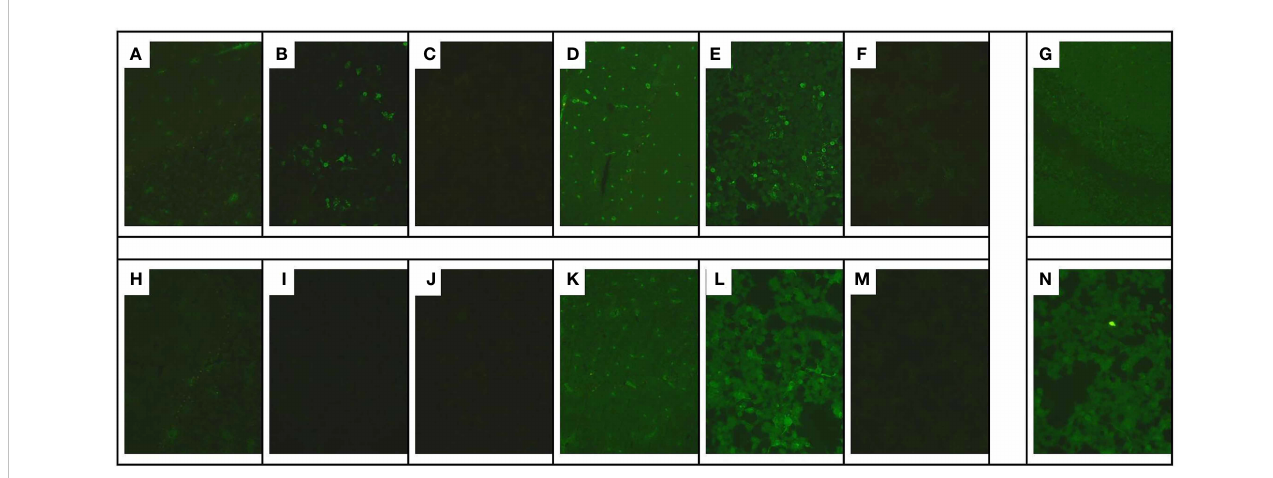
FIGURE 2 Immuno fl uorescence staining of monkey cerebellar tissues. Cryosections of the monkey cerebellum were incubated with patient serum and CSF in the fi rst step and with FITC-labeled goat anti-human IgG in the second step. Immuno fl uorescence of anti-NMDAR and anti-mGluR5 antibodies in the CSF and serum of the patient. Anti-mGluR5 and anti-NMDAR antibodies bound on mGluR5 and NMDAR antigens expressed in HEK293 cells, respectively, and visualized by the immuno fl uorescence of fl uorescein on the second antibody. (A) Tissue-based indirect immuno fl uorescence assay of CSF displayed anti-NMDAR antibody presenting as granular fl uorescence in monkey cerebellar granular layer cells. ×200 magni fi cation. (B) Positive reaction with transfected HEK293 cells expressing NMDAR after incubation with the patient ’ s fi rst CSF (B) (titer 1:3.2). ×200 magni fi cation. (C, I) Negative reaction with transfected HEK293 cells expressing mGluR5 after incubation with the patient ’ s fi rst CSF (C) and the repeated CSF (I) . ×200 magni fi cation. (D, G, J, M) Tissue-based indirect immuno fl uorescence assay of the patient ’ s fi rst serum (D) , second CSF (G) , second serum (J) , and third serum (M) showed no speci fi c form of fl uorescence in the monkey cerebellum. (E, K, N) Positive reaction with transfected HEK293 cells expressing NMDAR after incubation with the patient ’ s fi rst serum (titer 1:32) (E) , second serum (titer 1:32) (K) , and third serum (titer 1:10) (N) . (F) Positive reaction with transfected HEK293 cells expressing mGluR5 after incubation with the patient ’ s fi rst serum (F) (titer 1:10). ×200 magni fi cation. (H) Negative reaction with transfected HEK293 cells expressing mGluR5 after incubation with the repeated CSF (H) . ×200 magni fi cation. (L) Negative reaction with transfected HEK293 cells expressing mGluR5 after incubation with the repeated serum (L) . ×200 magni fi